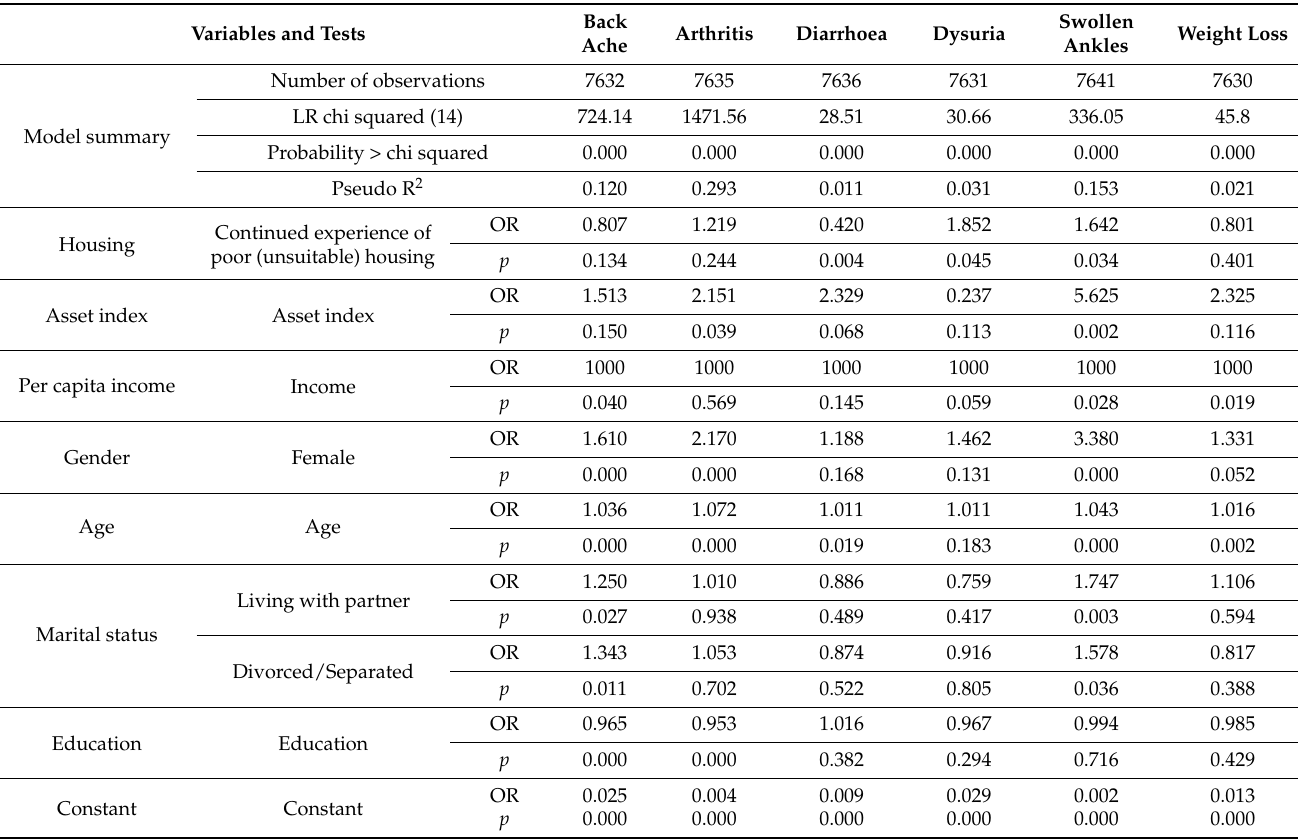
Table 5. Housing and poor health outcomes in the past 30